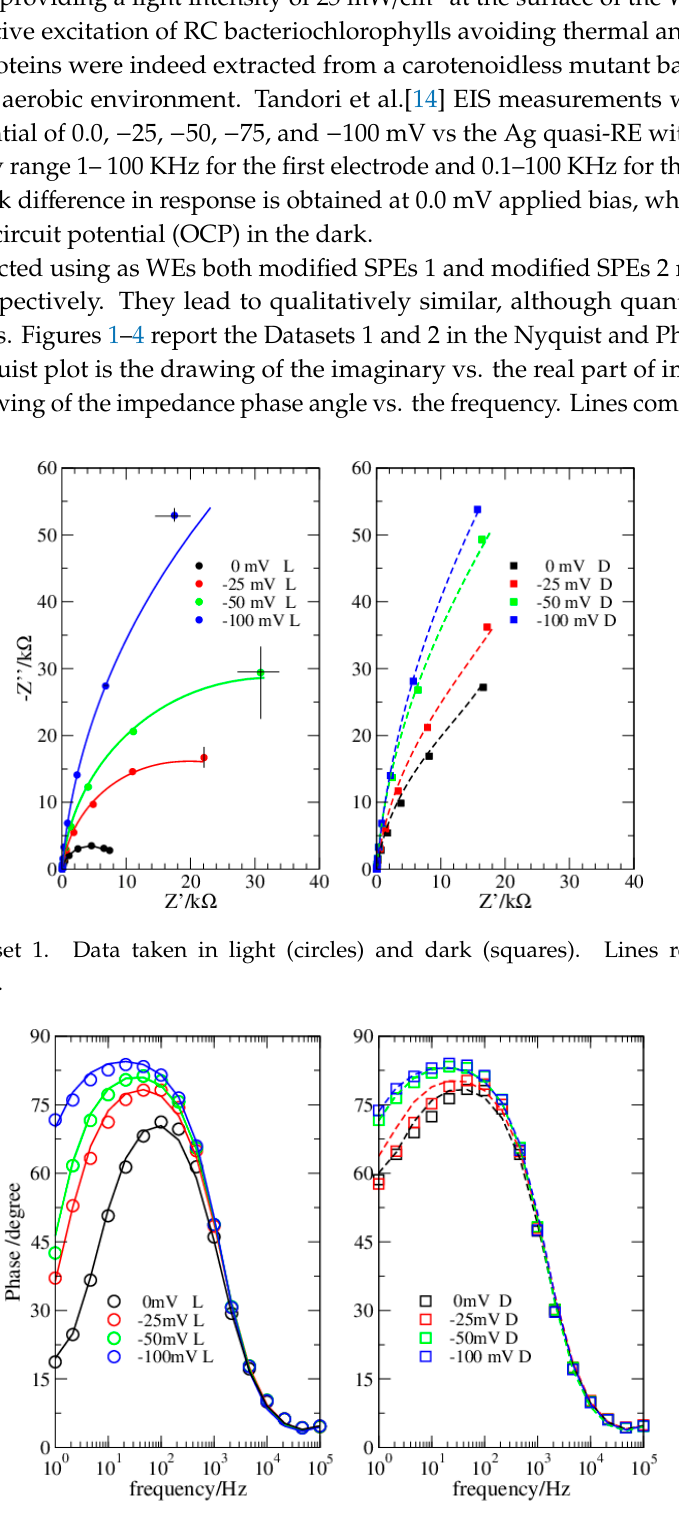
Figure 2. Dataset 1. Data in light (circles) and dark (squares). Lines reproduce data from simulations.